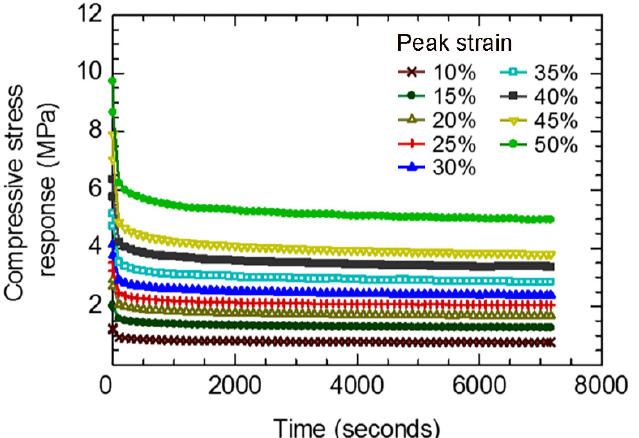
Figure 8. Compressive stress response vs. time of disc-A during viscoelastic period of stress relaxation test.